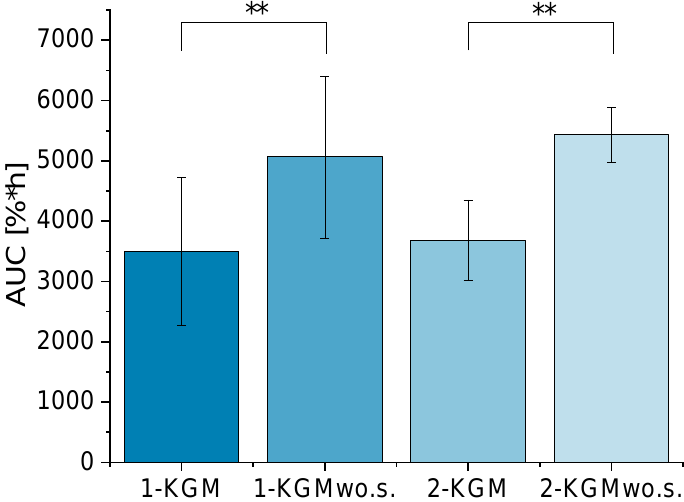
Figure 2. AUC of KGM and KGMwo.s. of researcher 1 and 2; researcher 1 analyzed 33-34 wells per sample (n well = 33 – 34), 6 pictures of the wound area were taken per well (n picture = 6); researcher 2: n well = 4, n picture = 5 – 6; mean ± SD, an independent t test was conducted with ** p ≤ 0.01.